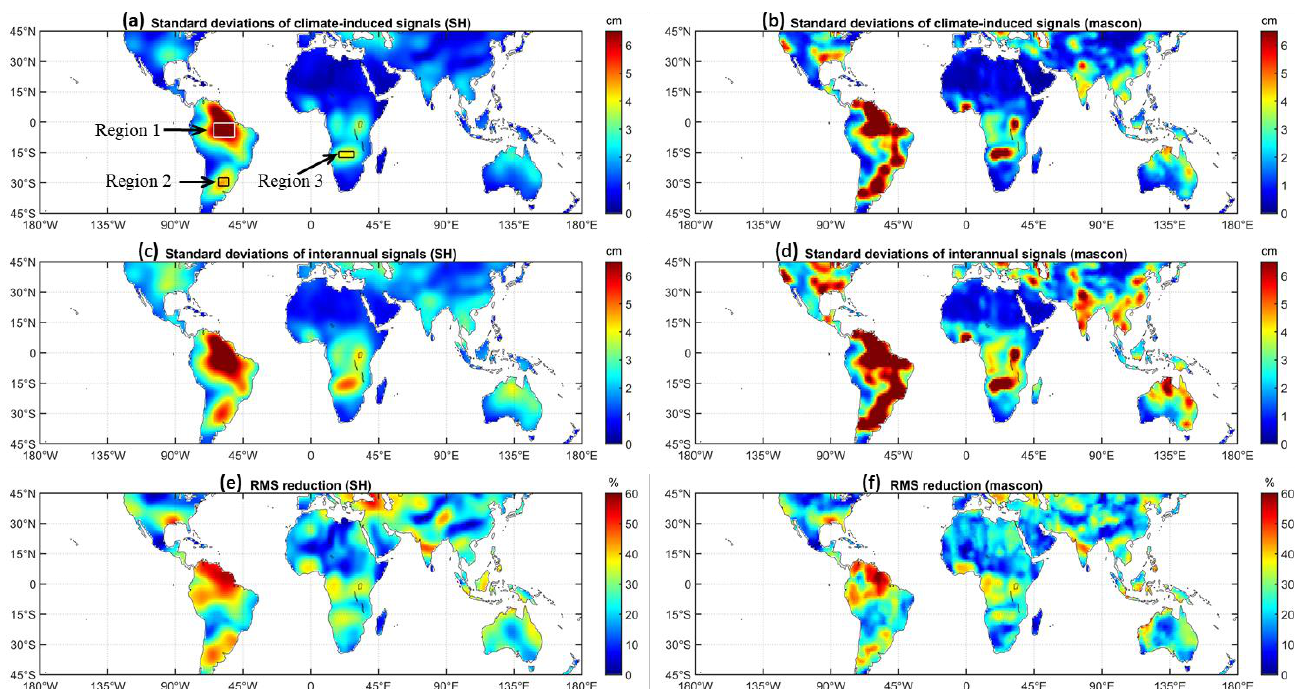
Figure 3. Comparisons between climate-induced TWS changes defined in Equation (6) and interannual TWS changes: ( a , b ) standard deviations of climate-induced TWS changes from GRACE SH and mascon solutions, ( c , d ) standard deviations of interannual TWS changes from GRACE SH and mascon solutions, and ( e , f ) RMS reductions between climate-induced TWS changes and interannual TWS changes from GRACE SH and mascon solutions.